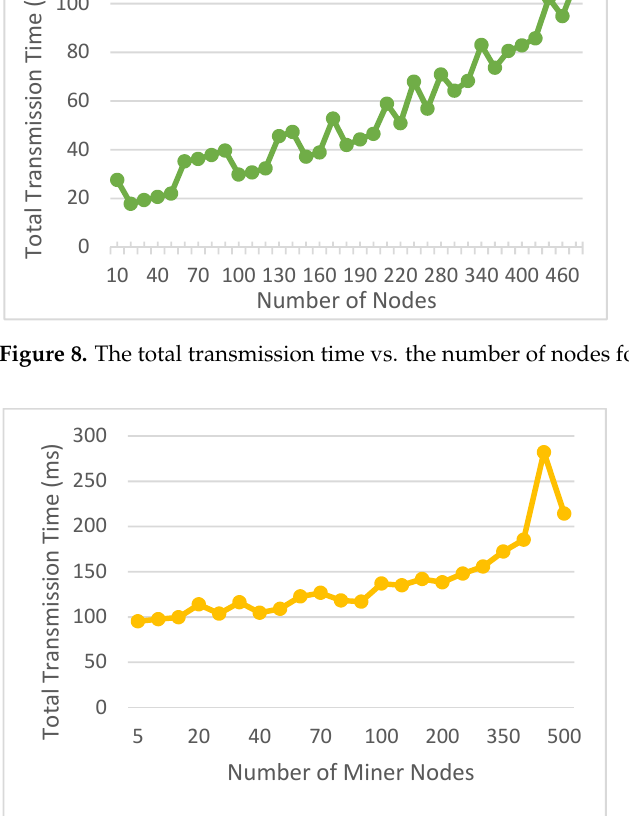
Figure 9. The total transmission time vs. the number of miner nodes in the PoW model.